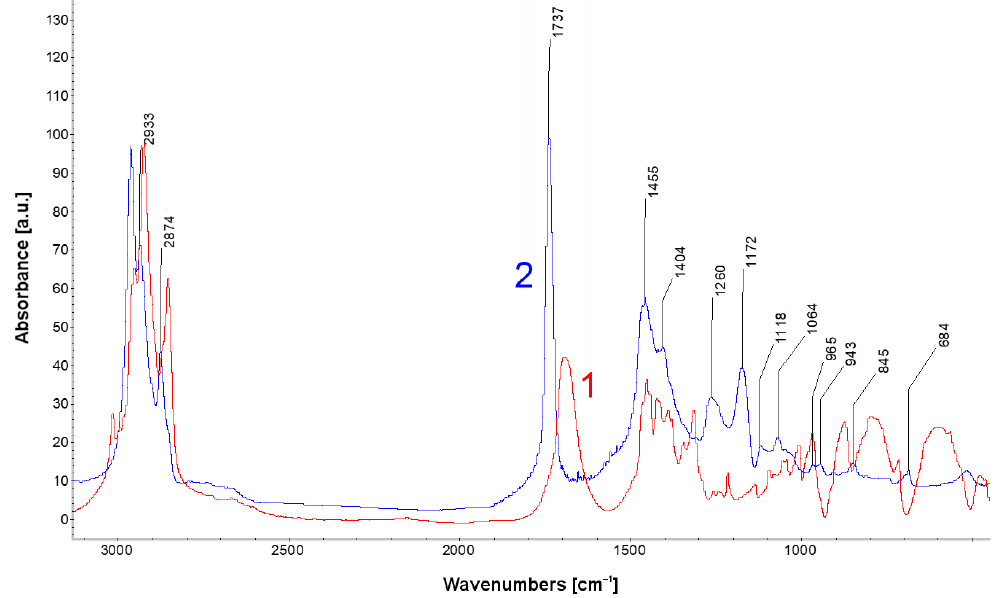
Figure 6. FTIR / ATR spectrum of lead specimen after cleaning with EDTA (1) compared with spectrum of EDTA acid (2).